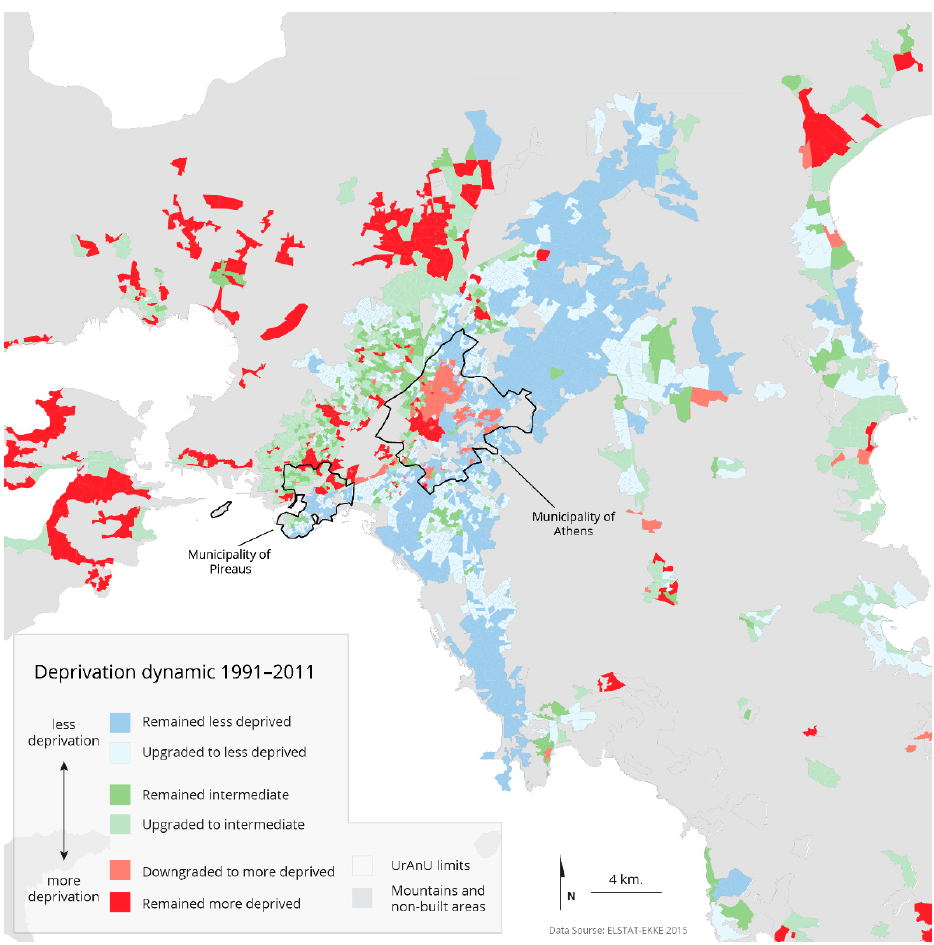
Figure 6. Change of deprivation status in Athens (1991–2011).